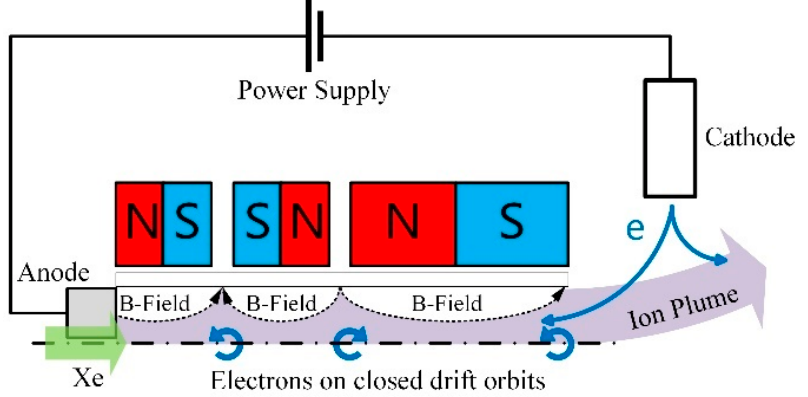
Figure 3. Schematic view of the cusped field thruster concept.